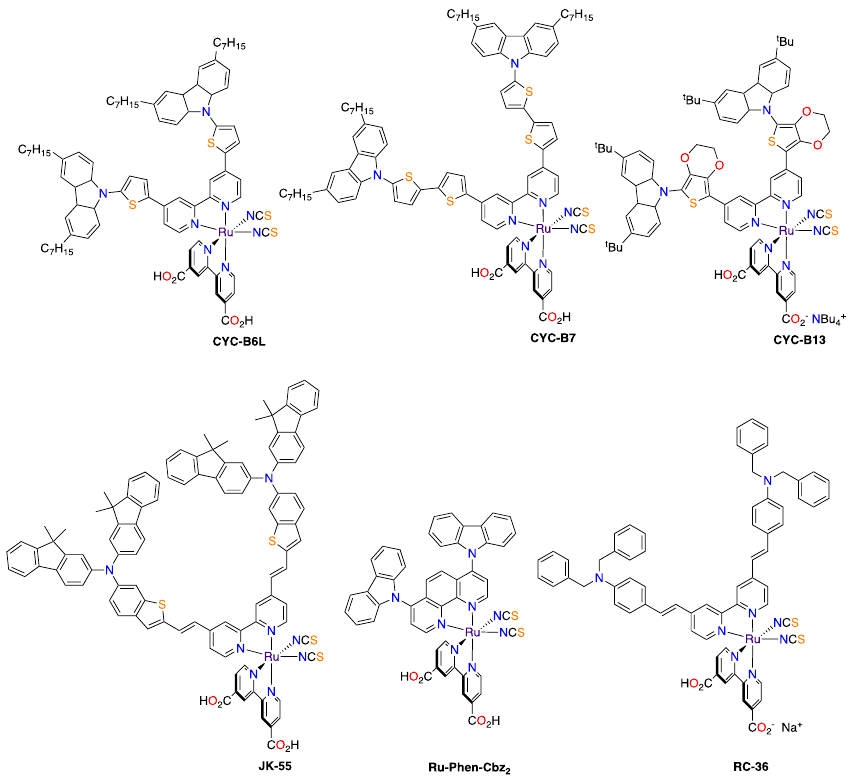
Figure 7. Some of the tris -heteroleptic isothiocyanate ligated Ru(II) complexes with arylamine-based substituents on the ancillary ligand.